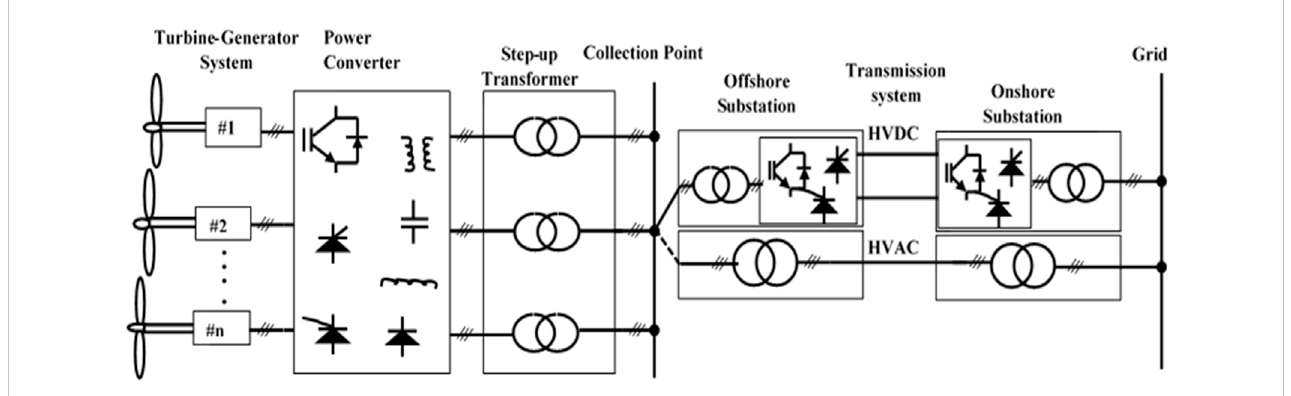
FIGURE 8 General scheme of an offshore wind farm.